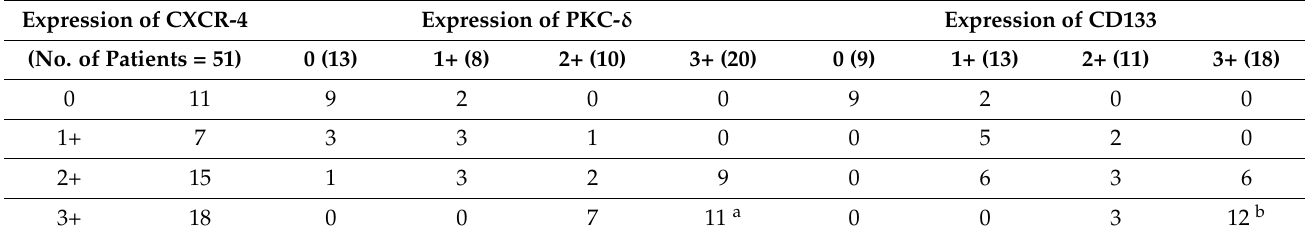
Table 3. Association among CXCR-4, PKC- δ and CD133 expression.